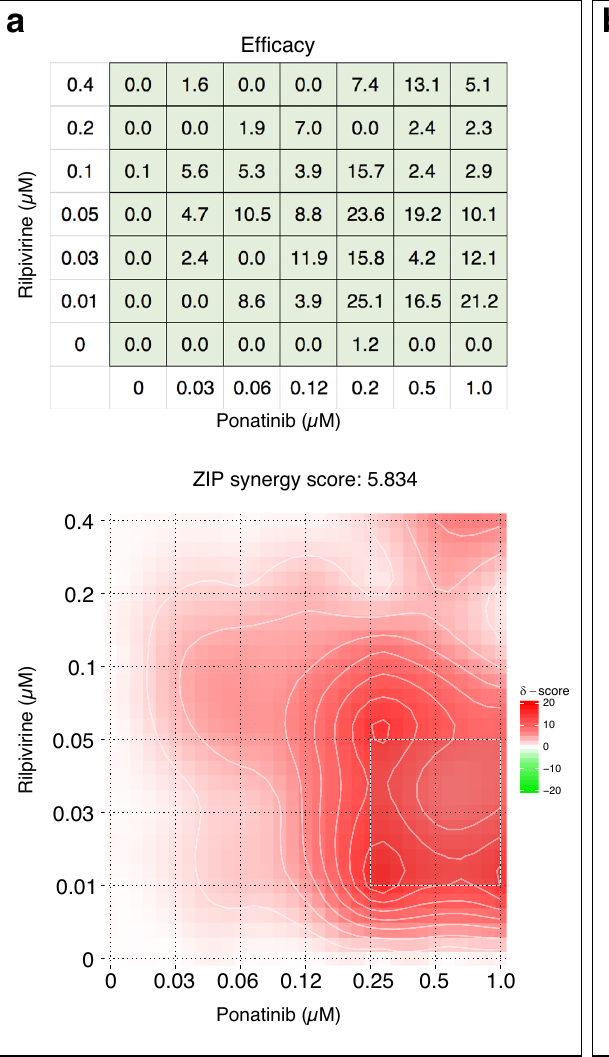
5.026.0 52.1 5.20.310.161.0